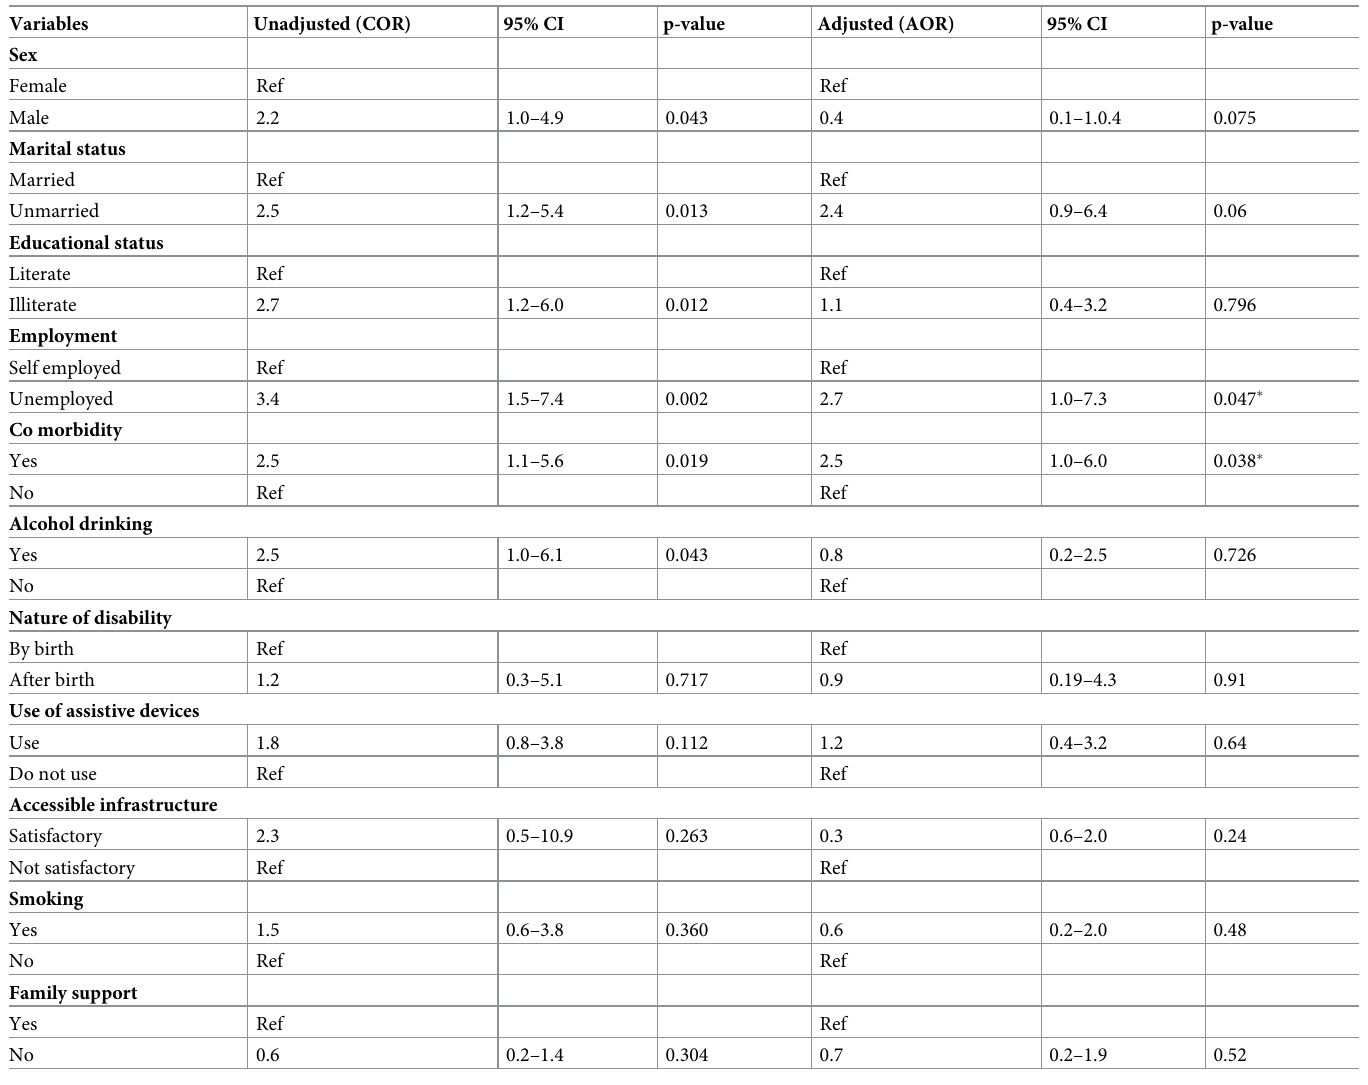
Table 4. Association of covariates with depressive